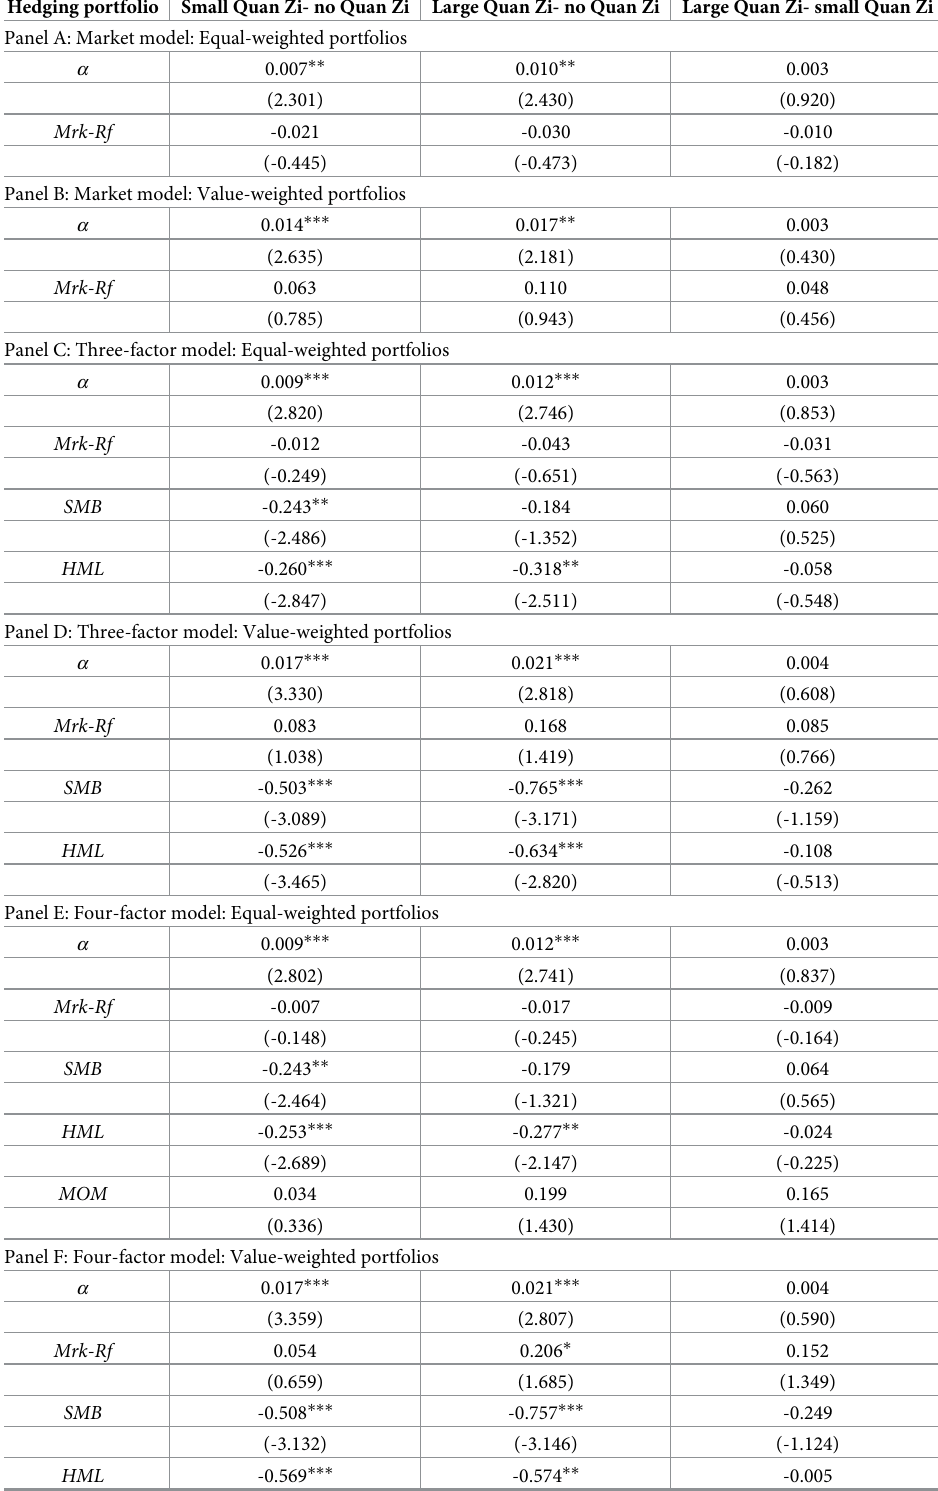
Table 14. Robustness test of CAPM, three-factor and four-factor